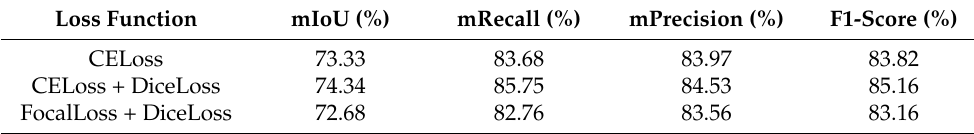
Table 2. Comparison of DeeplabV3plus segmentation results using different loss functions.